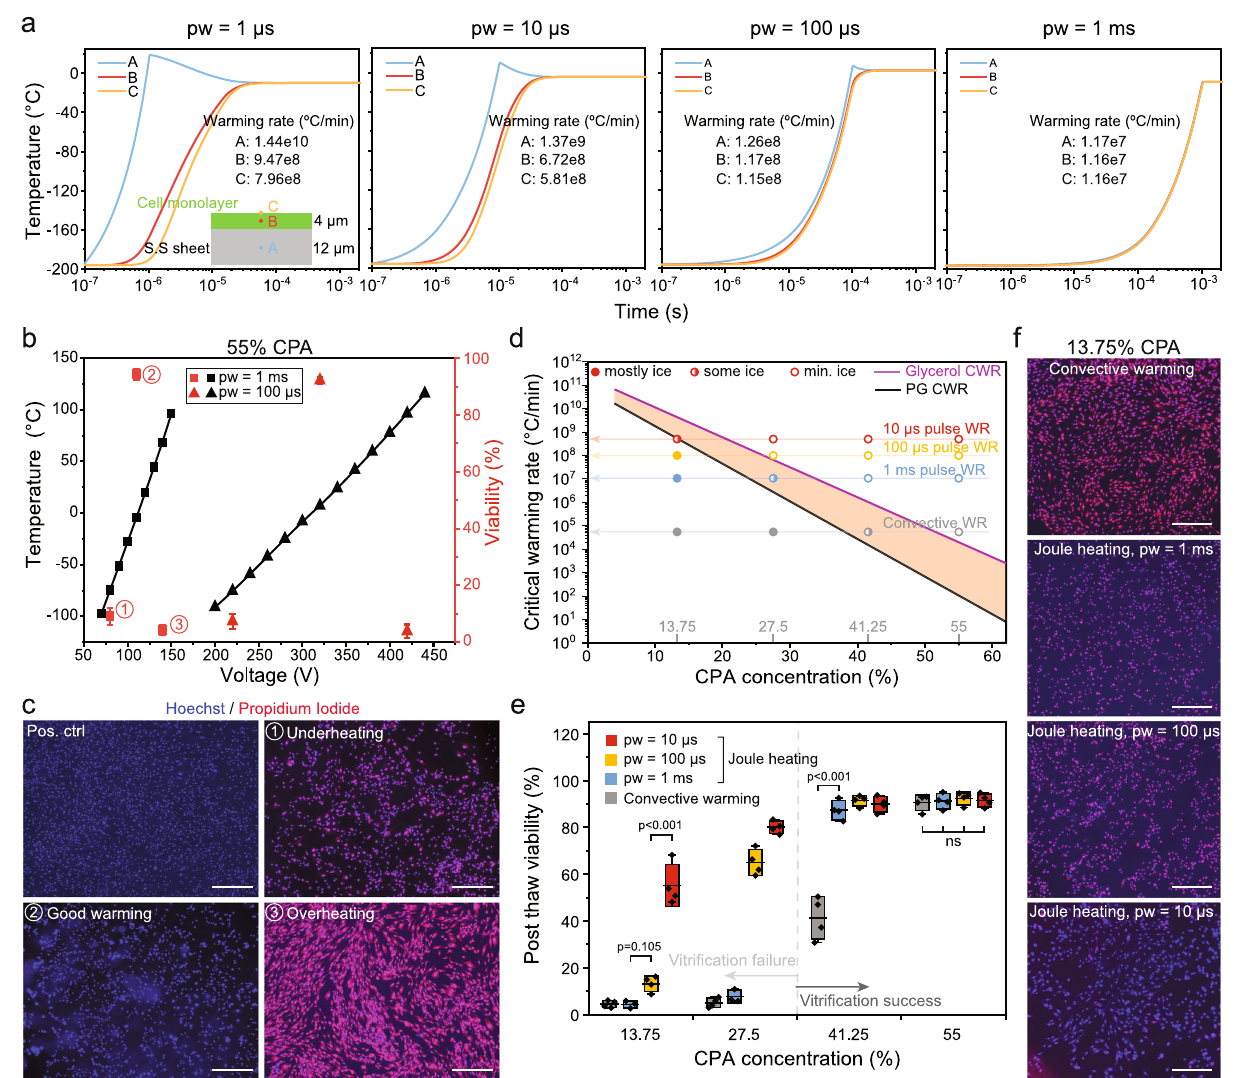
Fig. 3 | Adherent cells cryopreservation using joule heating. a Simulated tem- perature pro fi le of stainless steel (SS) sheet and cell monolayer under pulse width (pw)rangingfrom1 µ sto1ms(sharedyaxis).ThewarmingratesatthemiddleofSS sheet (point A), middle of cells (point B), and top of cells (point C) are displayed. b Simulated temperature (in black) and measured viability (in red) of human der- mal fi broblasts(HDFs)for1msand100 µ spulsewidthwithdifferentvoltages.VS55 (i.e., 55wt%) was used as the cryoprotective agent (CPA). n =4 independent experiments. Data presented as mean±s.d. c Merged Hoechst/Propidium Iodide (PI) images of HDF cells. Conditions including underheating, good warming, overheating (for joule heating, as numbered in b ), and positive control are shown. The pulse width is 1ms. Scale bar is 500 µ m. d Estimated critical warming rate (CWR) plotted as a function of CPA concentration. Propylene glycol (PG, good glass-forming tendency) and glycerol (poor glass-forming tendency) were used to